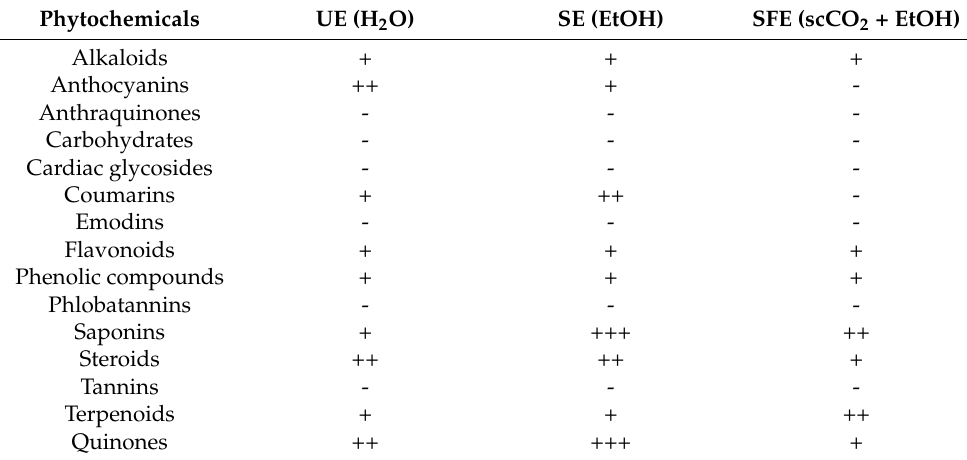
Table 1. Screening for various phytochemicals in AS extracts obtained by ultrasonic extraction (UE; solvent H 2 O), Soxhlet extraction (SE; solvent EtOH), and supercritical fluid extraction (SFE; solvent scCO 2 , co-solvent